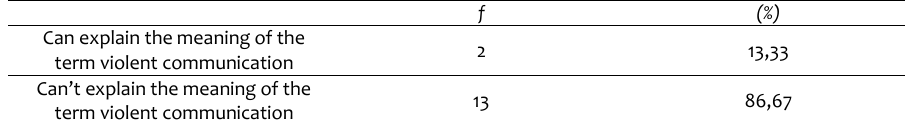
Table 2 . Students' explanations of the meaning of violent communication before research